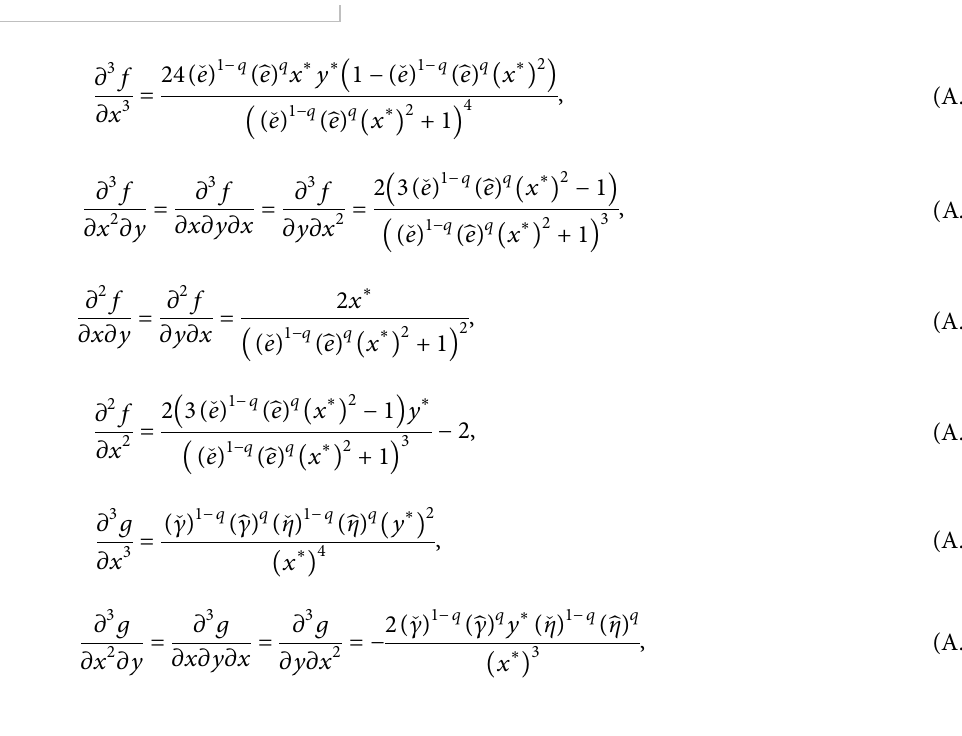
Table 7: Diferent values of c corresponding to q . q 0 0.3